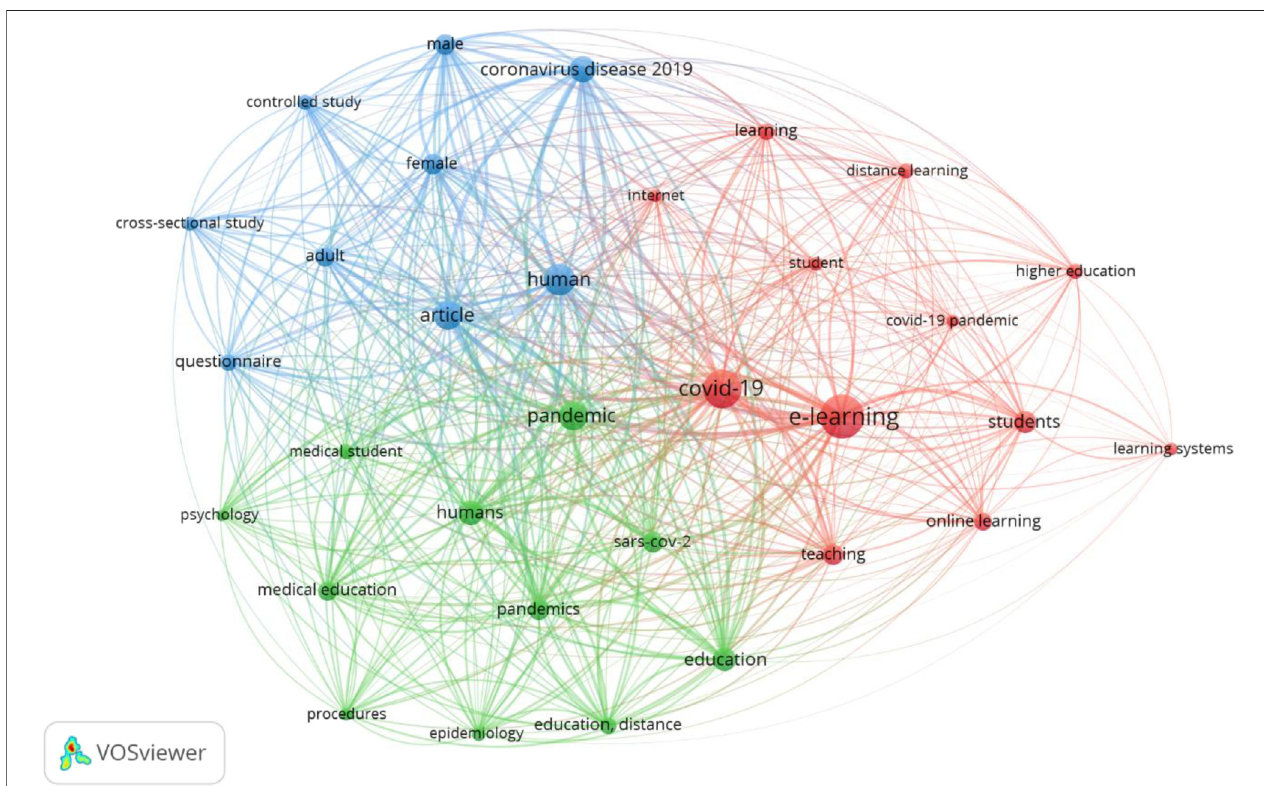
FIGURE 6 | Network map of keywords occurrence in the fi eld of e-learning and COVID-19.